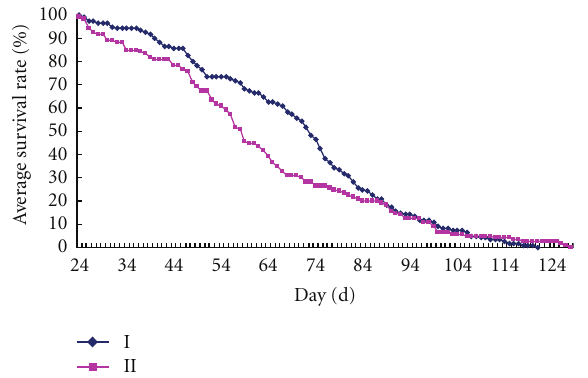
Figure 2: Survival curves of adults of two strains of B.